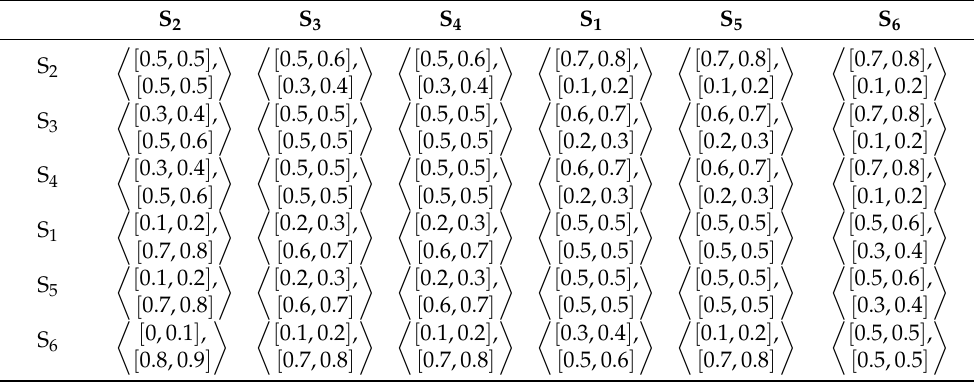
Table 13. Aggregated decision interval matrix in IVPF–AHP for the sub-criteria S (CI = 0.0426034, CR = 0.0343576).